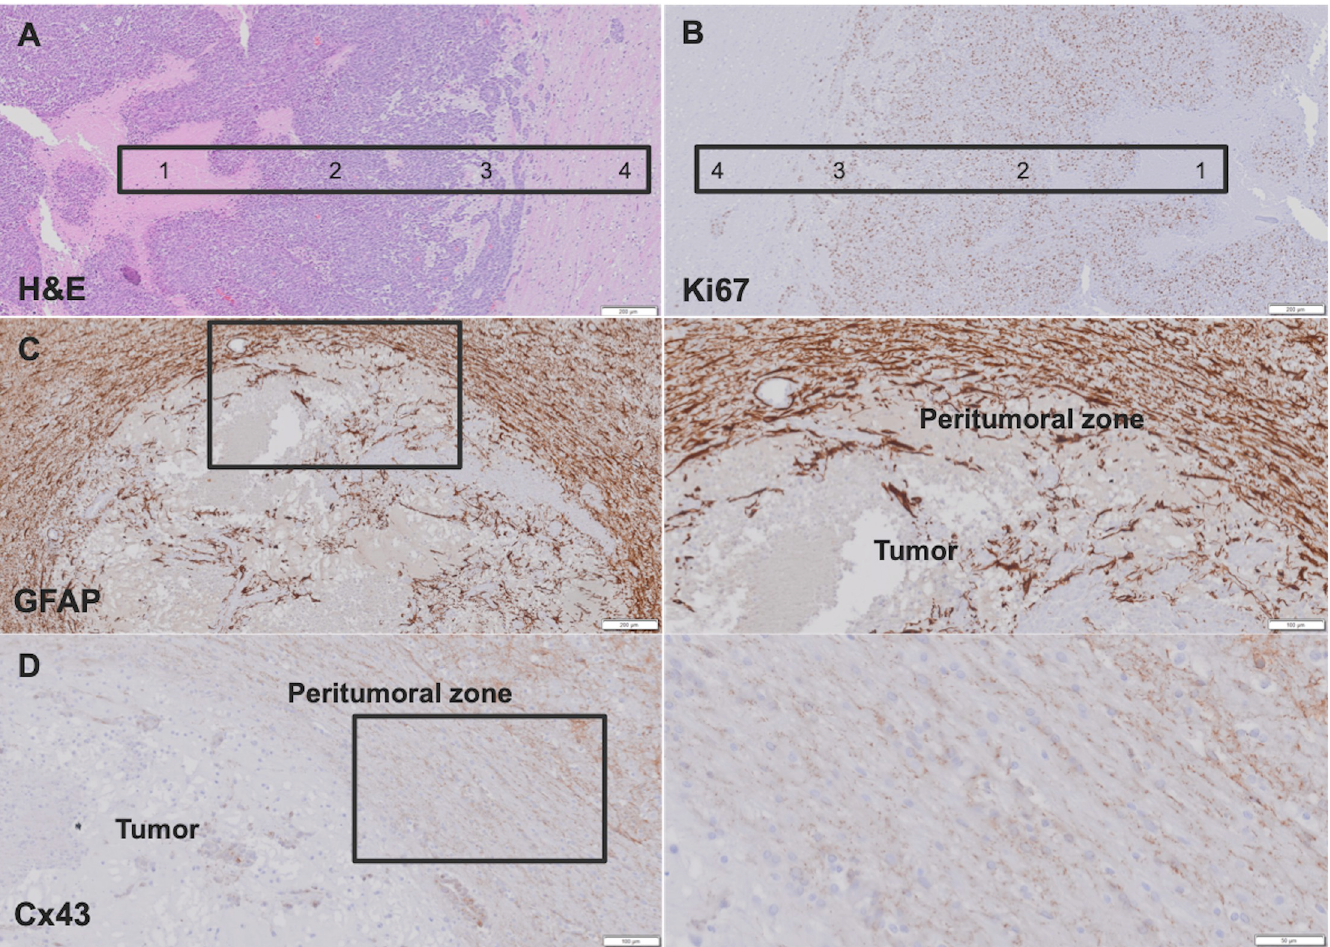
Fig 4. Histological analysis performed on paraffin-embedded slices of resected GB of a rat. A. H&E staining confirmed the presence of GB characterized by central tumor necrosis (1), tumor (2) and the peritumoral zone with infiltrating cancer cells (3) surrounded by healthy brain tissue (4). B. Immunohistochemistry for Ki67 indicated that GB is highly proliferative, except for the necrotic tumor core: tumor necrosis (1), tumor (2), peritumoral zone with infiltrating cancer cells (3) and healthy brain tissue (4). C-D. Immunohistochemistry for GFAP and Cx43 demonstrated GFAP-positive reactive astrocytes and enhanced Cx43 expression at the peritumoral